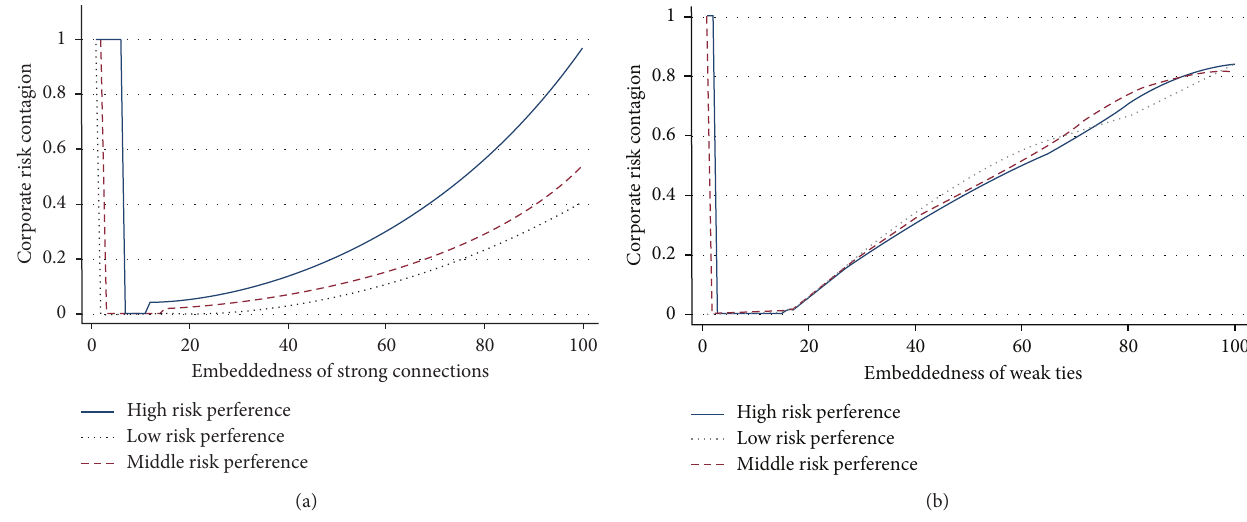
Figure 5: Risk preferences and risk contagion process. (a) Strong connection networks. (b) Weak ties